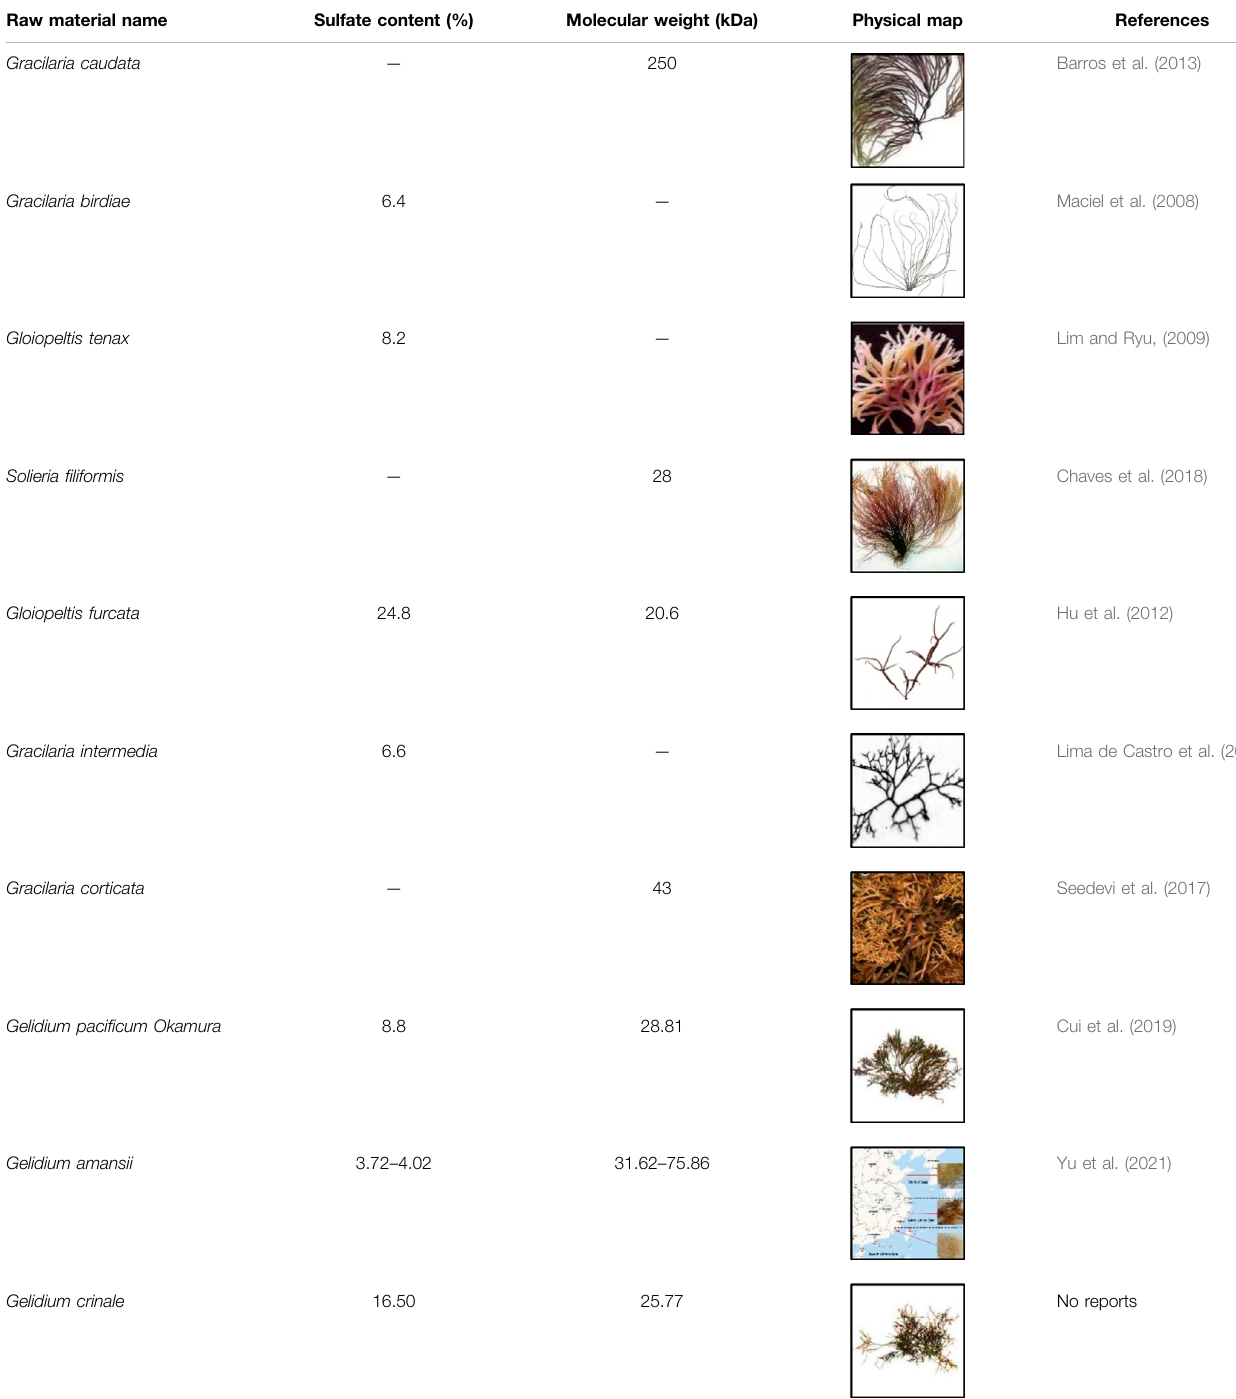
TABLE 2 | Comparison of the sulfuric acid content and molecular weight of different types of red